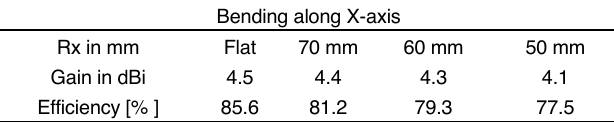
FIGURE 11. Bending evaluation on different radii (Rx) in mm TABLE III. Analysis of bending performance